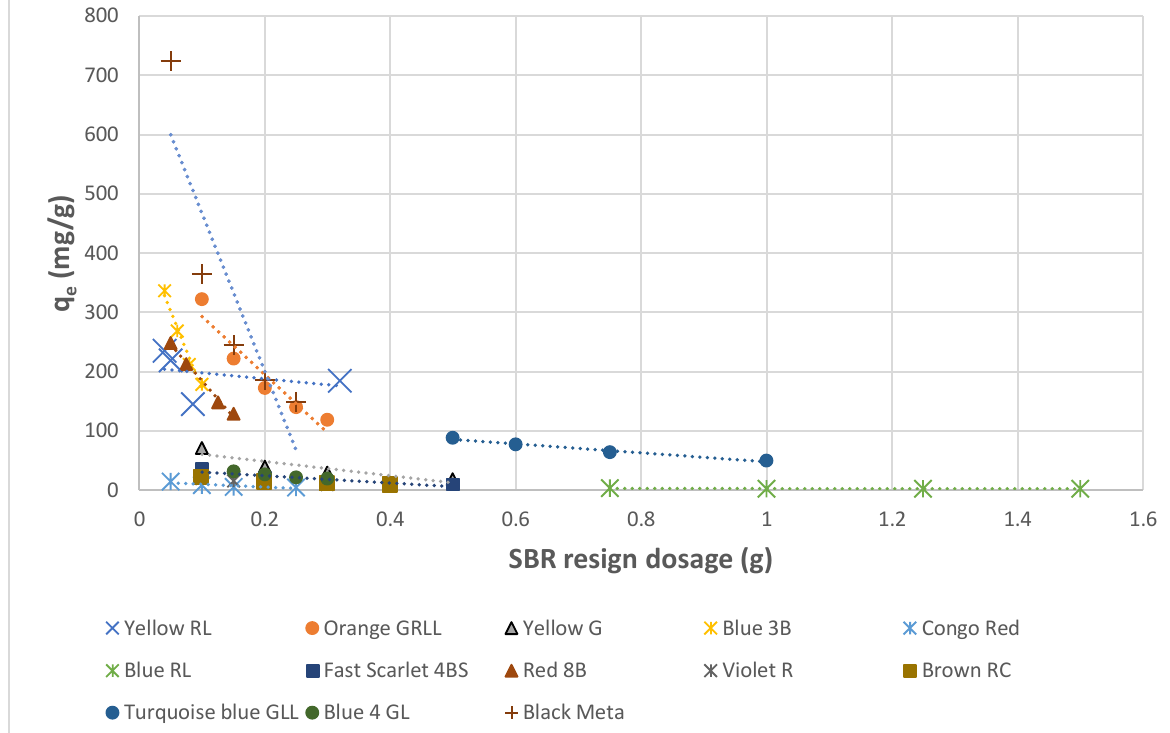
Molecules 2022 , 26 , x FOR PEER REVIEW Figure 16. Impact of Amberlite IRA 958 Cl resin quantity on the adsorption of direct dyes.